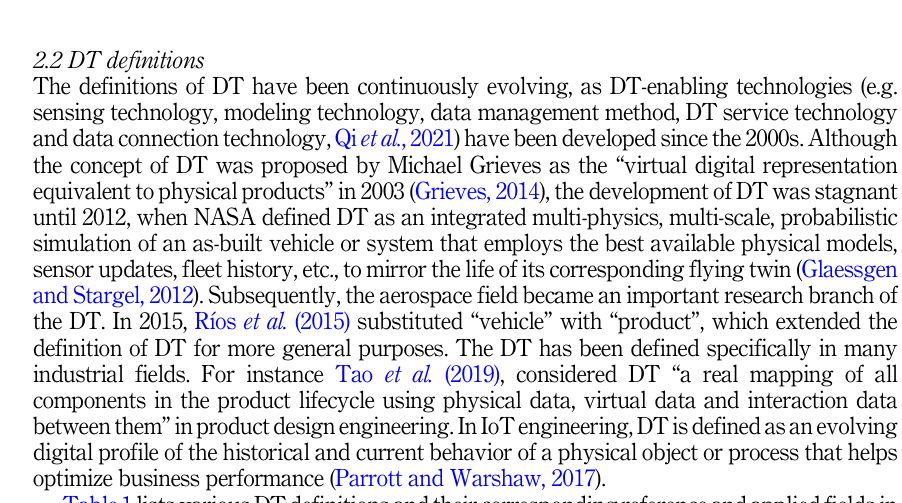
Figure 2. Brief history of